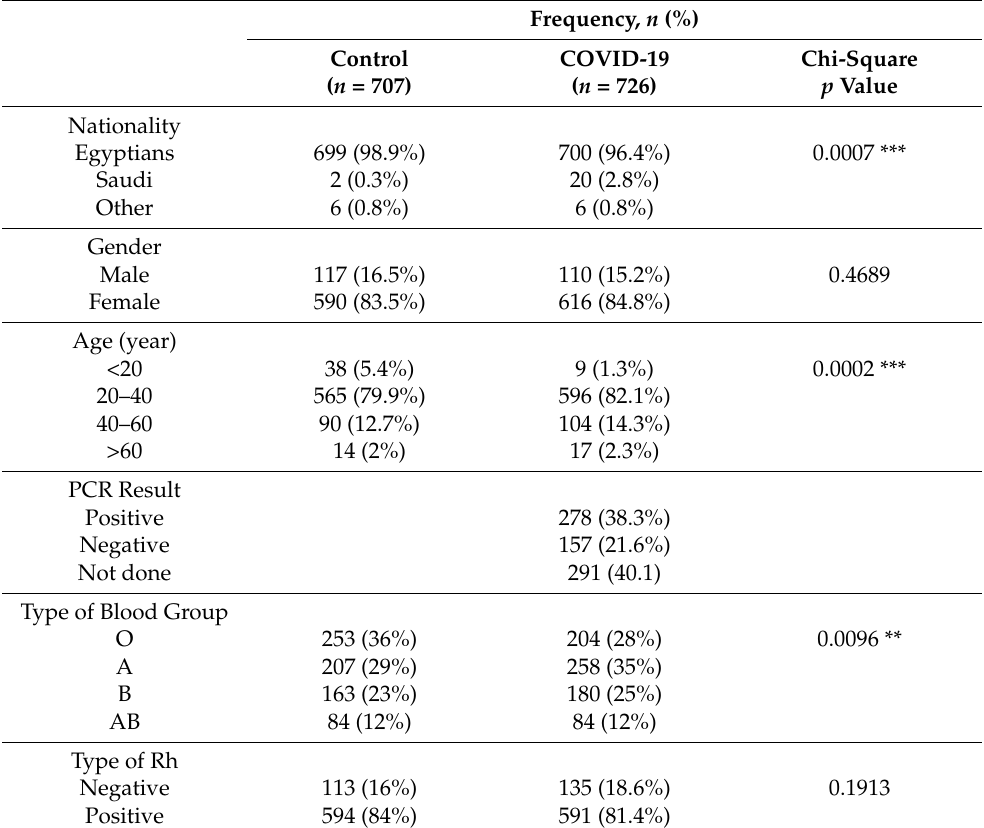
Table 1. Demographic characteristics and blood grouping of the study